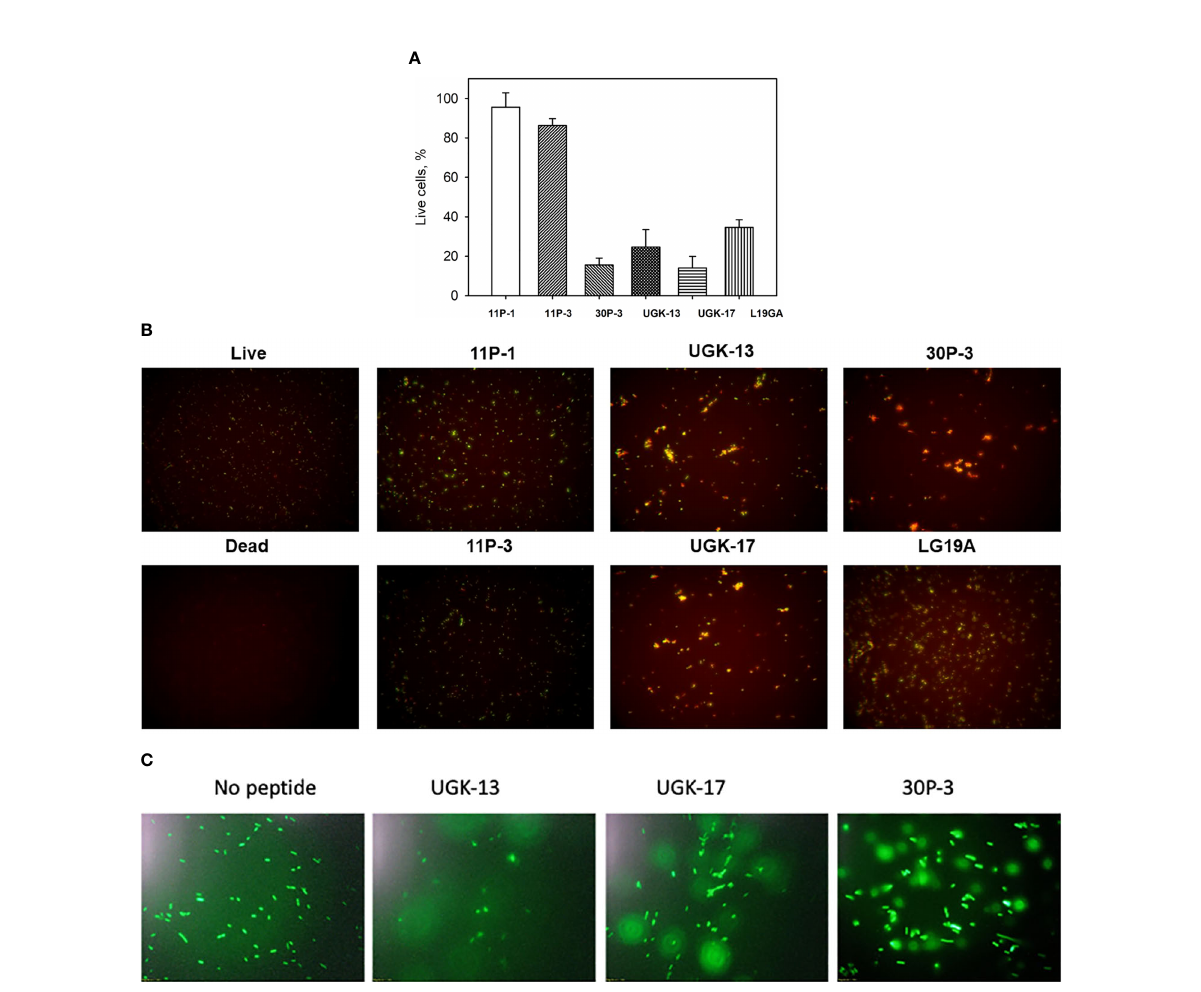
FIGURE 2 Two-color fl uorescence assay after 1 h of peptide incubation of Eschrichia coli BL21 cells (5 × 10 5 cfu). (A) Percentage of live cells by treatment with different peptides at 20 m M concentration. (B) Fluorescent images of live and dead bacteria for the same experiment as (A) . (C) Single-color fl uorescence images of green fl uorescent protein (GFP)-labeled BL21 after 20 m M peptide treatment for 24